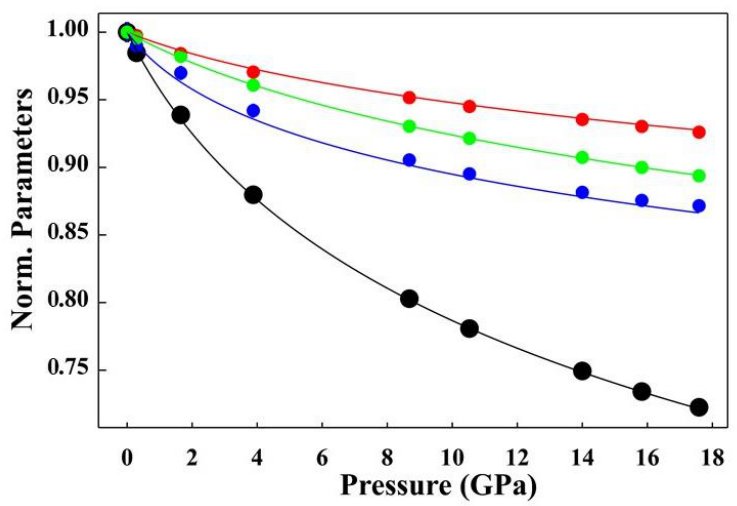
Figure 2. Lattice parameters and volume of mascagnite at different pressures ( a lattice parameter— red dots, b lattice parameter—blue dots, c lattice parameter—green dots, V volume cell—black dots). The values are normalized to the room pressure value to highlight the reciprocal difference in the lattice parameters’ compressibilities.